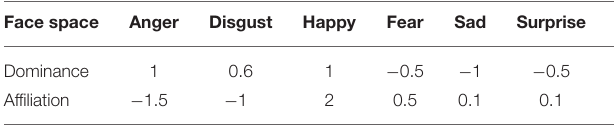
TABLE 2 | The relative dominance and affiliation values for each emotion expression found by Knutson